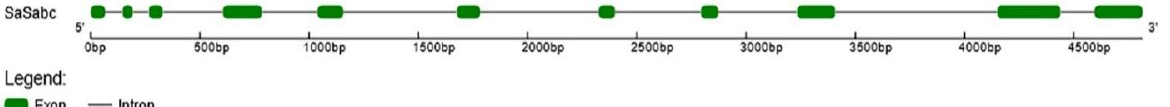
Figure 3. Structure of SaSabc gene.